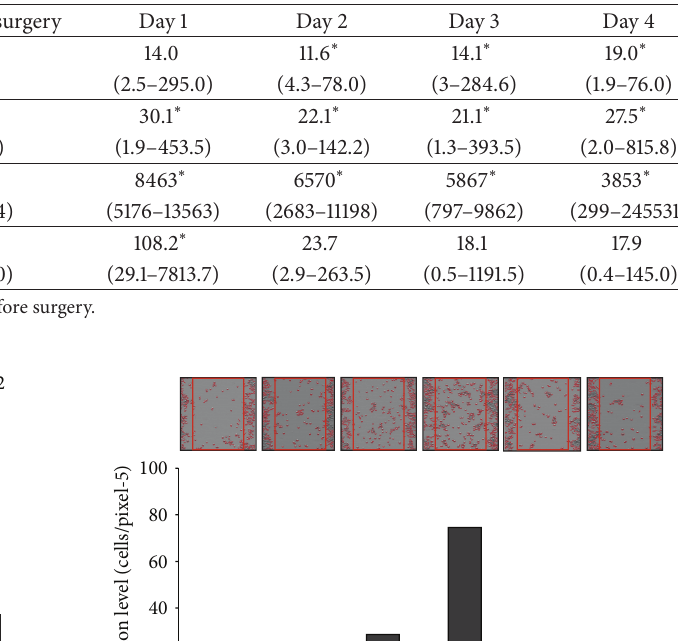
Table 2: Cytokine levels in peritoneal fluids of patients during and after surgery.